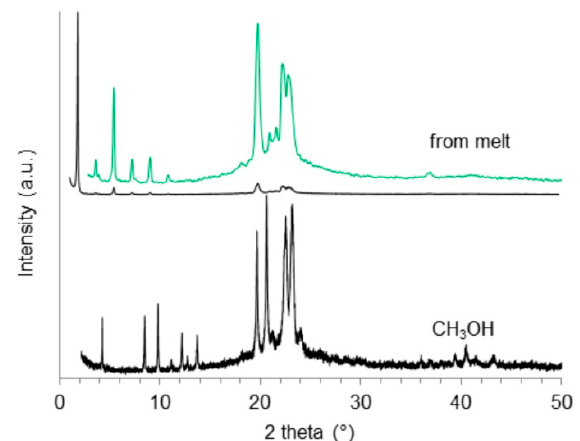
Figure 8. Experimental powder patterns for (R) -9-HSA crystallized from CH 3 OH (bottom trace) and for the solid obtained after recrystallization from melt (upper trace, black line, with the 5 × magnification of the 2.8–50° region, in green).